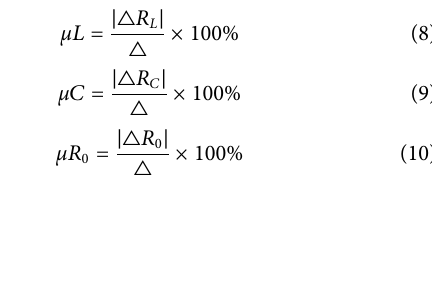
FIGURE 4 Abrupt change point detected by the sequential